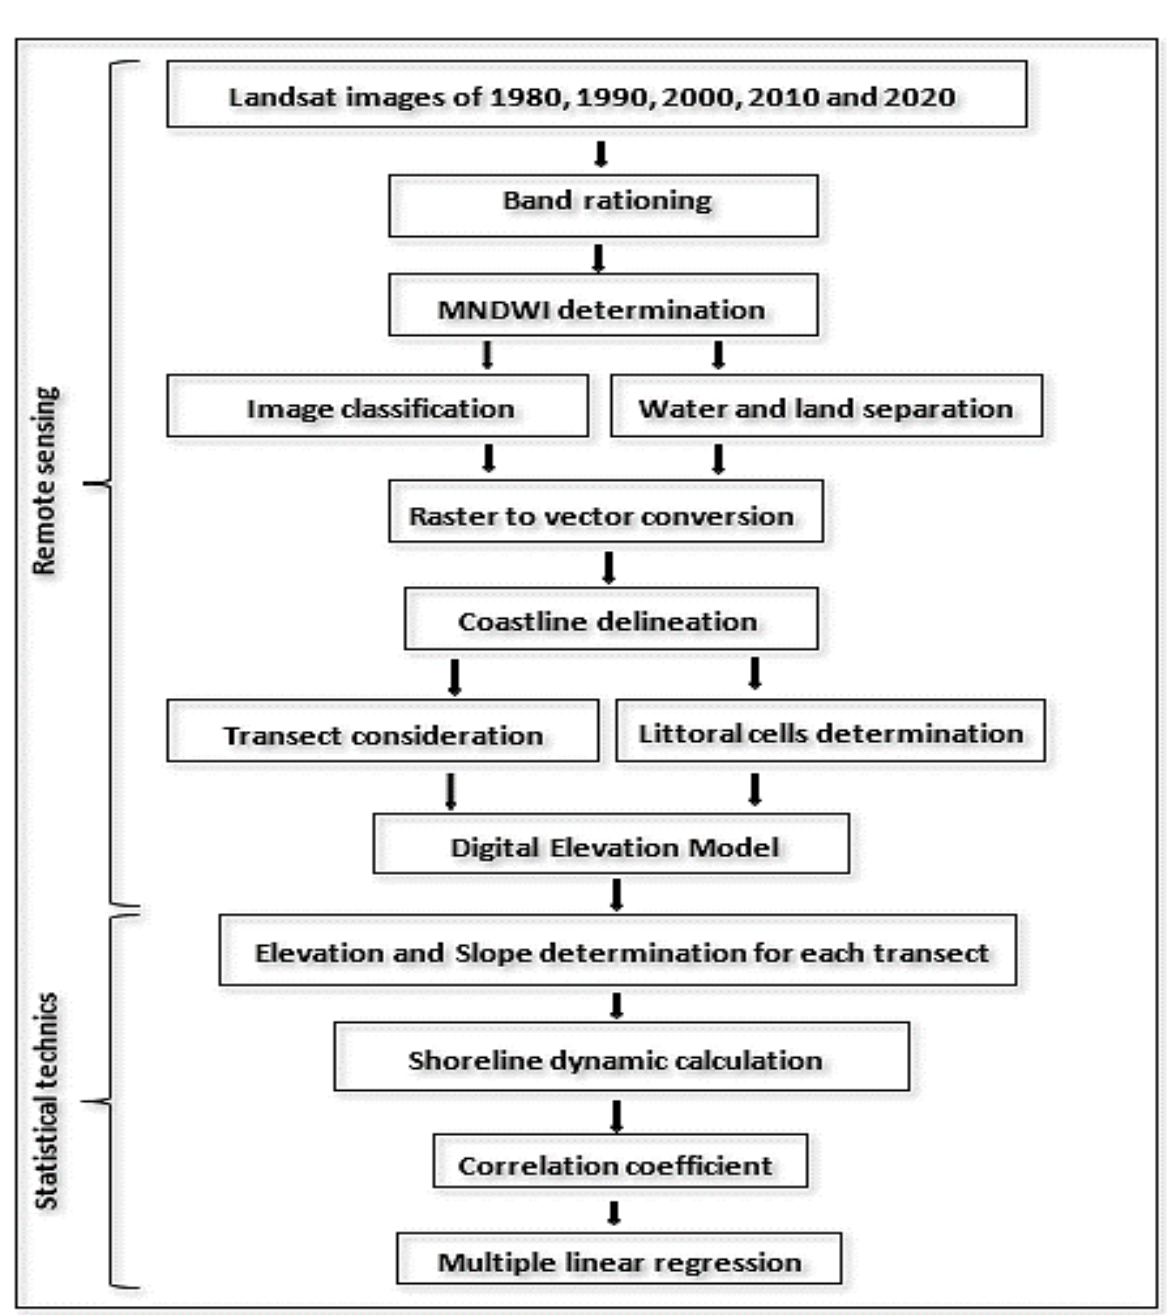
Figure 3. Flow chart summarizing the methodology adopted in this study [26] accessed on 9 July 2021.